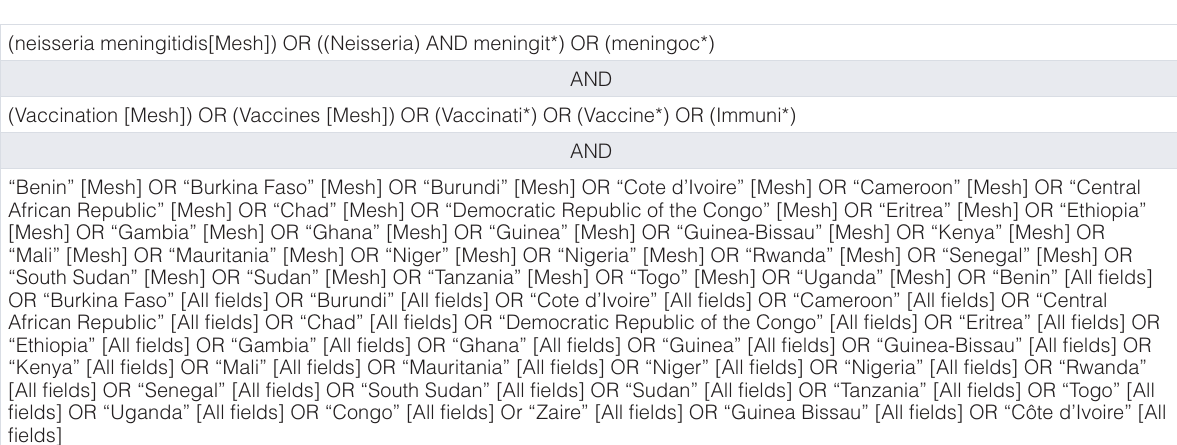
Table 2. Planned search syntax for